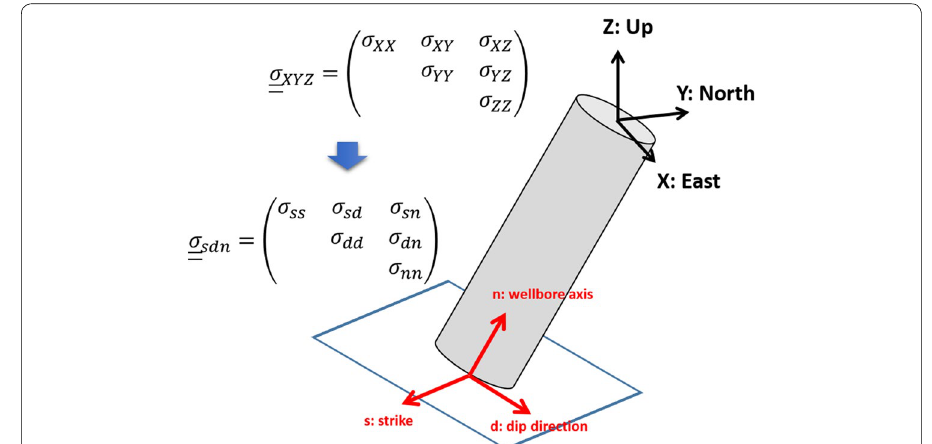
Fig. 5 Sketch of the stress state rotation. The transformed stress is obtained through (i) rotation of principal stresses from 30° along the vertical axis to be in the global coordinate system ( Y south–north, X west–east, Z up–down); (ii) rotation of 40° along the vertical axis to align with the dip direction of the wellbore ( Y 2 horizontal axis aligned with dip direction, X 2 horizontal axis perpendicular to dip direction, Z vertical axis); (iii) rotation of 30° along X 2 to be in the wellbore axis coordinate system (axis parallel to the dip direction of the plane perpendicular to the wellbore axis, noted as “ d ”, axis parallel to the strike direction of the plane perpendicular to the wellbore axis, noted as “ s